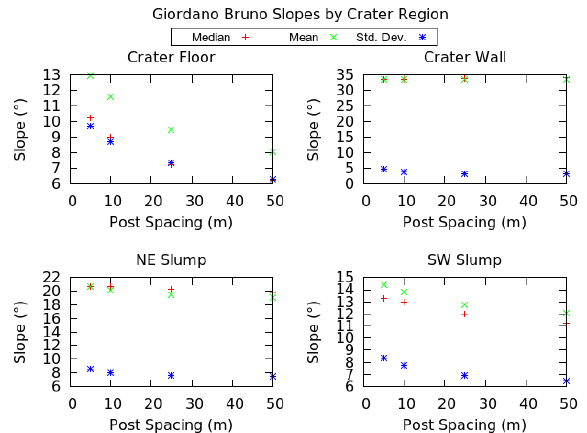
Figure 7. Mean, median, and standard deviation of slopes for regions of Giordano Bruno crater, calculated for post spacings of 5 m, 10 m, 25 m, and 50